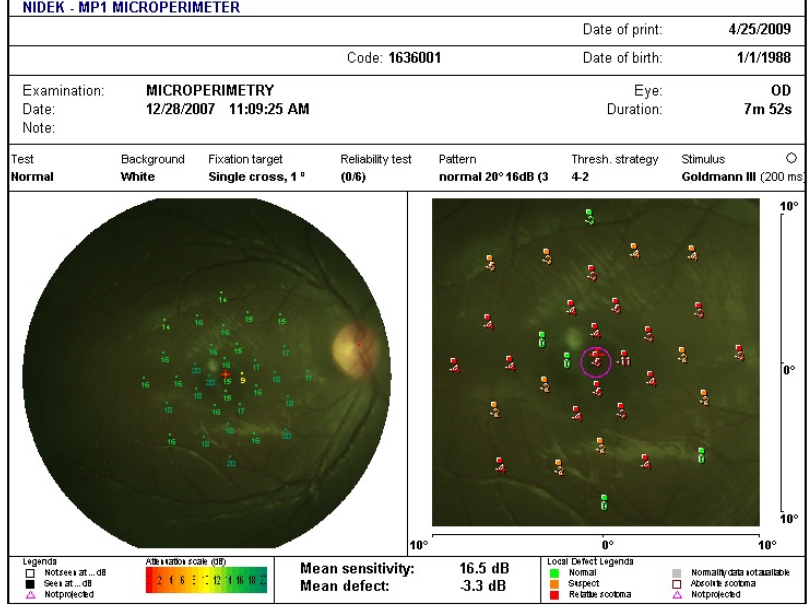
Figure 6: Macular perimetry reveals normal retinal sensitivity values with absence of